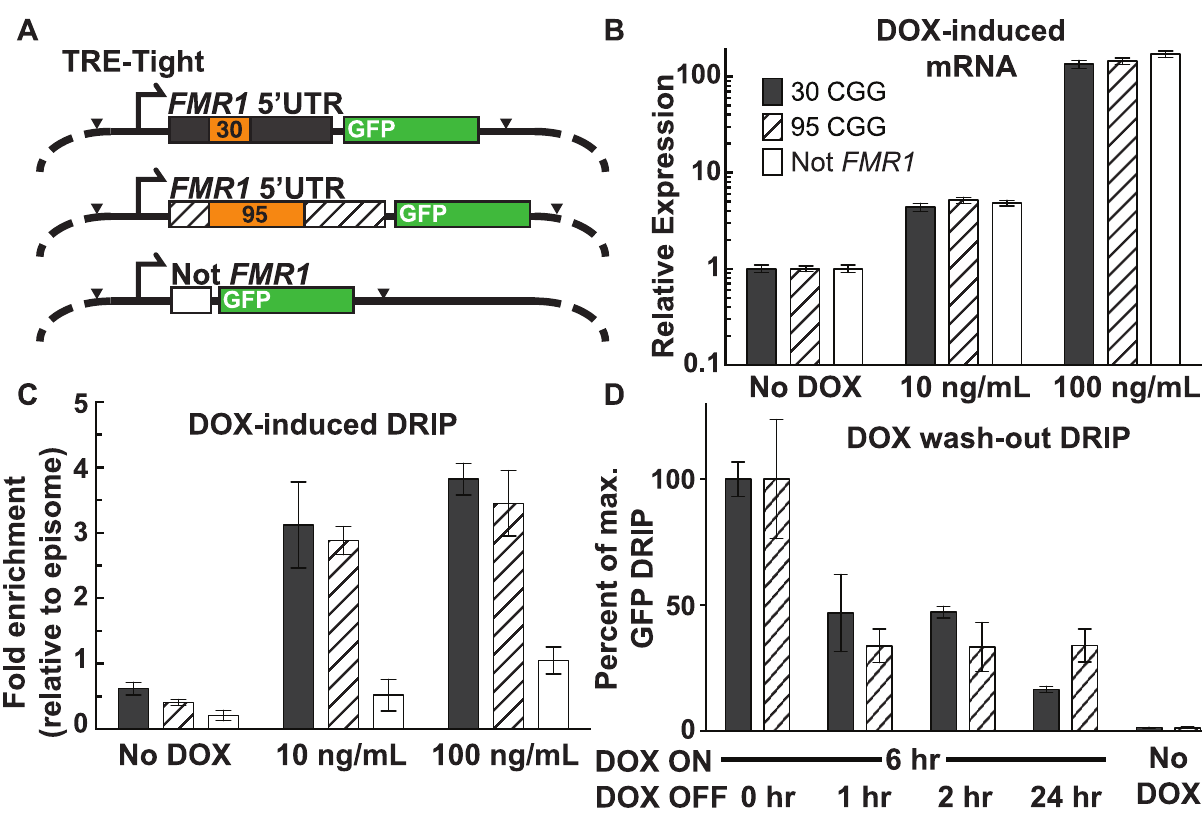
Figure 3. Effect of transcription and repeat length on FMR1 R-loop formation. ( A ) Schematic of DOX-ON constructs with short or expanded FMR1 CGG repeats or non- FMR1 sequence, each with GFP reporter tags. Black arrowheads mark sites of restriction enzyme cleavage prior to DRIP, with EcoRI cutting at the start of the FMR1 5 9 UTR and XbaI cutting at the end of EGFP . ( B ) mRNA expression relative to non-induced cells for each construct. Error bars: SEM from 2 biological replicates. ( C ) DRIP fold enrichment of GFP fragment relative to the episome backbone. Error bars: SEM from 3 biological replicates. ( D ) DRIP percentage of input normalized to peak recovery (6 hours DOX ON) of GFP fragment at 0, 1, 2, and 24 hours post DOX washout, and No-DOX treatment. Error bars: SEM from 3 biological